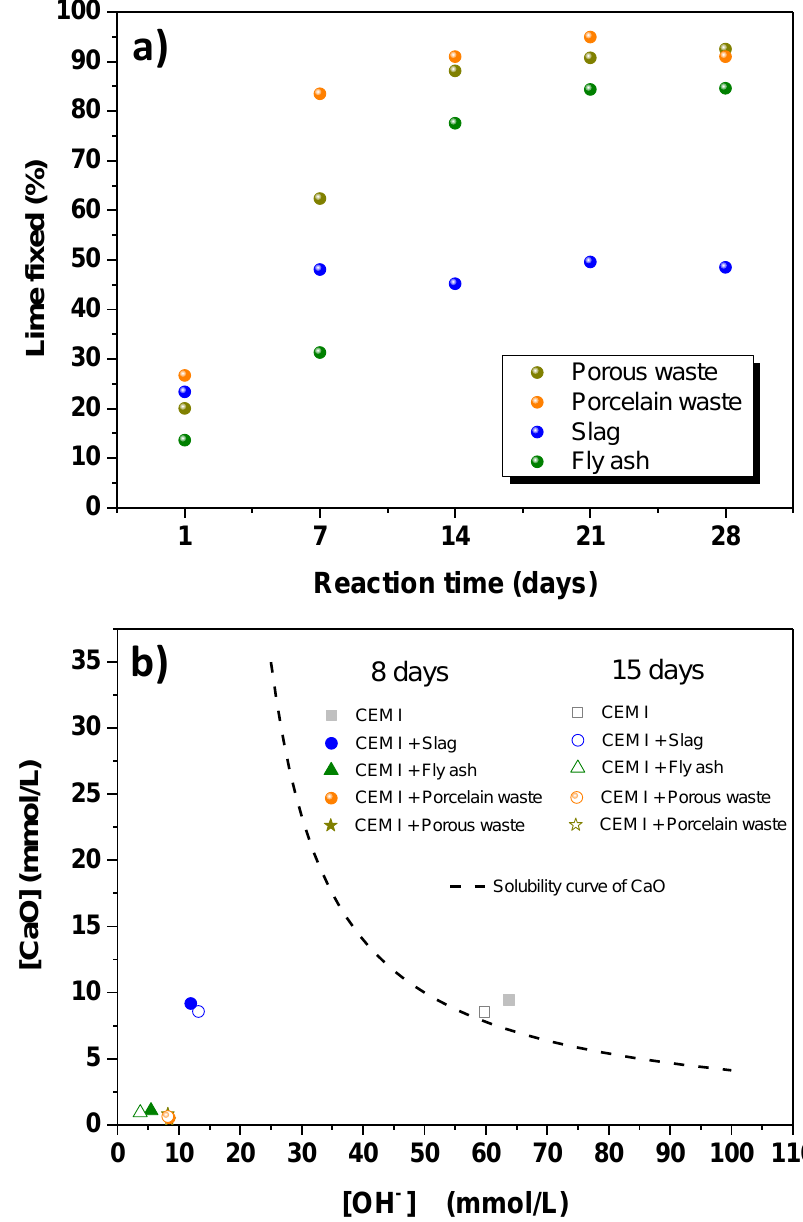
Figure 2. ( a ) Lime fixed to different wastes used in this study over time (1, 7, 14, 21 and 28 days); ( b ) pozzolanicity test for studied cement paste compositions at 8 days (filled symbols) and 15 days (hollow symbols).